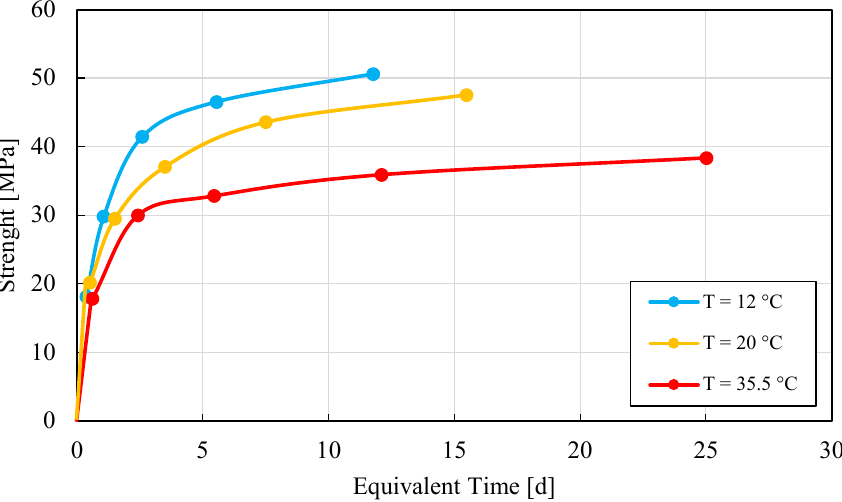
Figure 9. Strength–Equivalent Time test value at three different temperatures. Each point corresponds to the mean value among 3 to 4 observations.